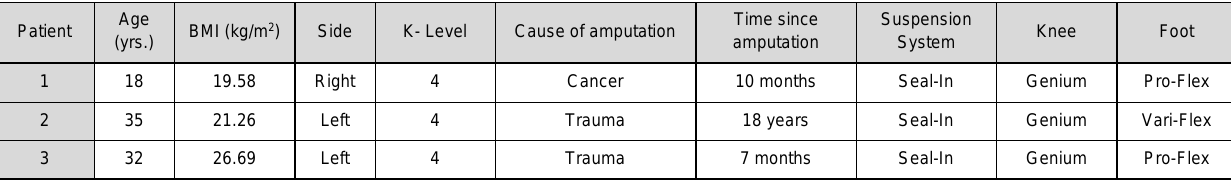
Table 1: Demographic and prosthetic information of the sample. BMI= Body Mass Index.